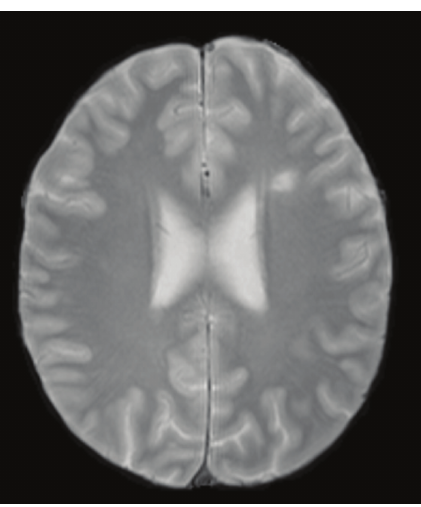
Figure 3: Female patient with low lesion load and significant cognitive deficit. The PD axial image illustrates the presence of few lesions in the supratentorial white matter, despite the cognitive